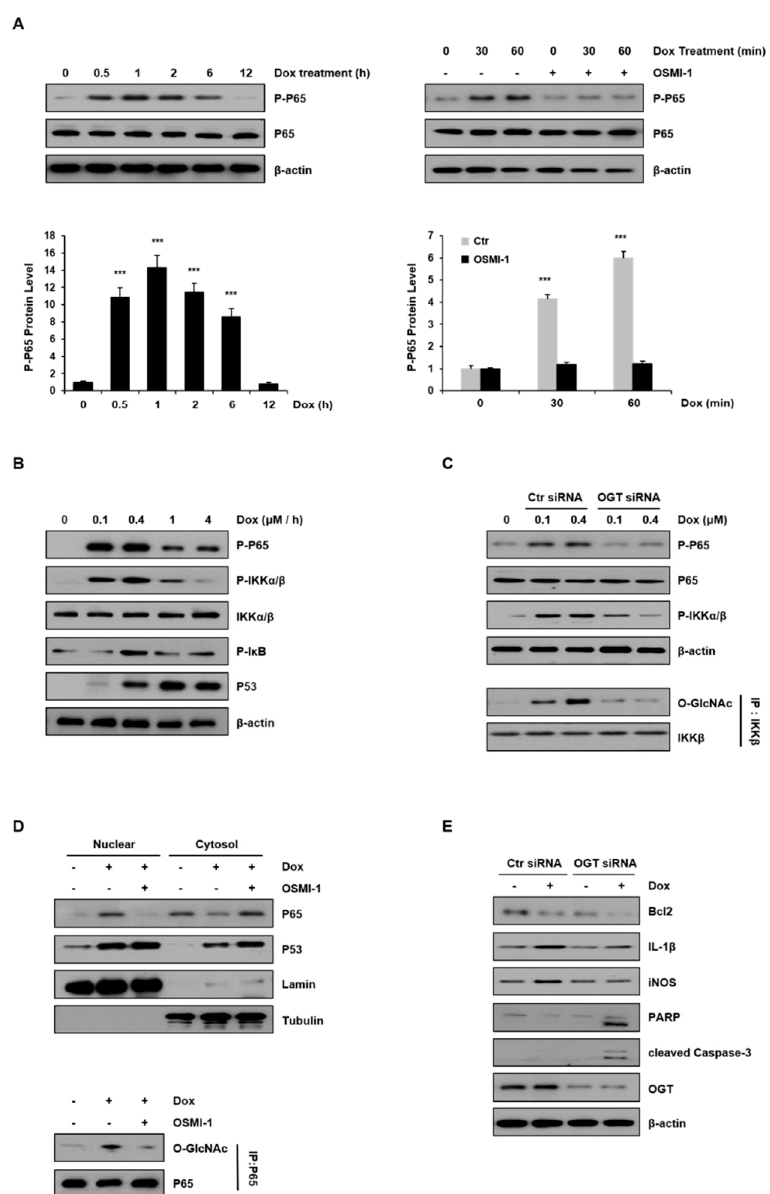
Figure 4. Inflammatory NF- κ B signaling was modulated by DOX and OSMI-1. ( A ) Levels of phospho-p65 in HepG2 cells treated with DOX (0.4 μ M) were monitored by Western blot for up to 12 h (left). HepG2 cells were treated with DOX (0.4 μ M) for up to 60 min in the absence or presence of OSMI-1 (20 μ M) and levels of phospho-p65 were analyzed (right). The lower two graphs show the relative amount of these proteins as fold increase. Data represent three independent experiments. *** p < 0.005 compared with the control group. ( B ) HepG2 cells treated with DOX (0 to 4 μ M) for 1 h were analyzed by Western blot using antibodies against phospho-p65, phospho-IKK α / β , phospho-I κ B, and p53. ( C ) After transfection with control or OGT siRNAs, HepG2 cells were treated with DOX (0.1 and 0.4 μ M) for 1 h. Levels of phospho-p65 and phospho-IKK α / β in HepG2 cells were analyzed by Western blot. Immunoprecipitation analysis using the IKK β antibody was performed (lower panel) followed by immunoblotting using the GlcNAc antibody. Immunoprecipitation analysis was performed using whole-cell lysate, and the GlcNAc levels were assessed using the same amount of precipitates. ( D ) OSMI-1 (20 μ M) pretreated with or without HepG2 cells were treated with DOX (0.4 μ M) for 1 h. The